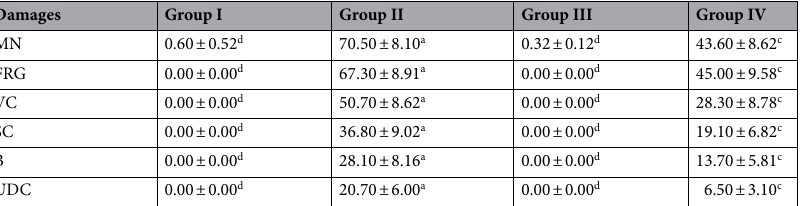
Table 5. Frequency of MN and CAs frequency in experimental groups. MN micronucleus, FRG fragment, VC vagrant chromosome, SC sticky chromosome, B bridge, UDC unequal distribution of chromatin. 1.000 cells were counted in each group for MN and CAs. Means shown with different letters (a–d) on the same line are statistically significant (p < 0.05).